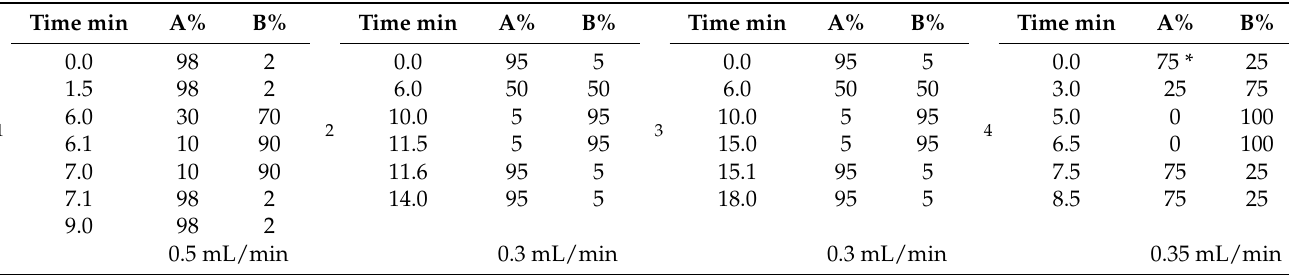
Table 1. Tested elution gradients and mobile phase composition.